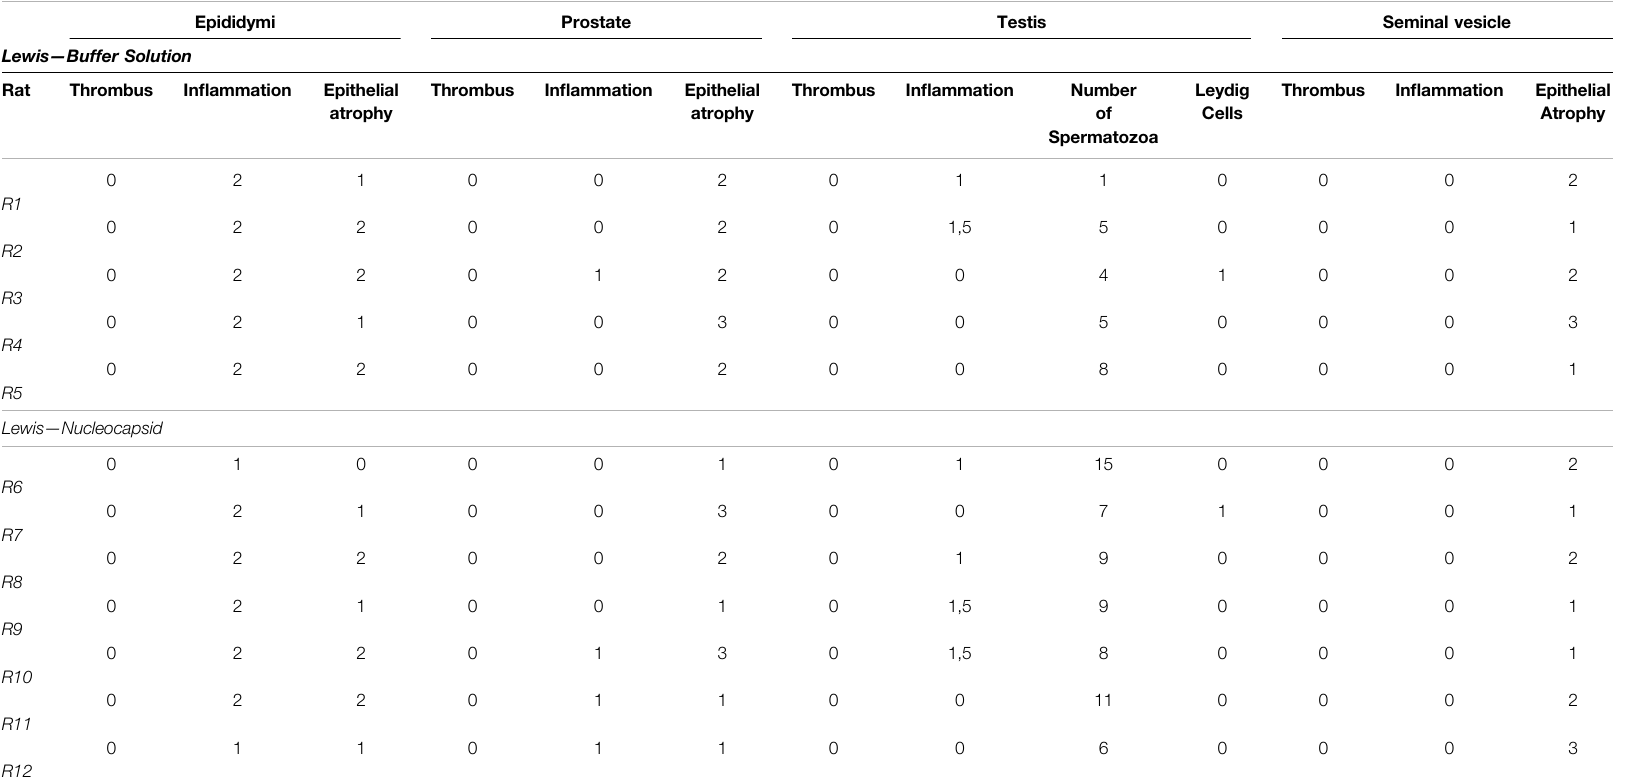
TABLE 1 | Histopathological characteristics of epididymis, prostate, testis, and seminal vesicles. Epididymi Prostate Testis Seminal